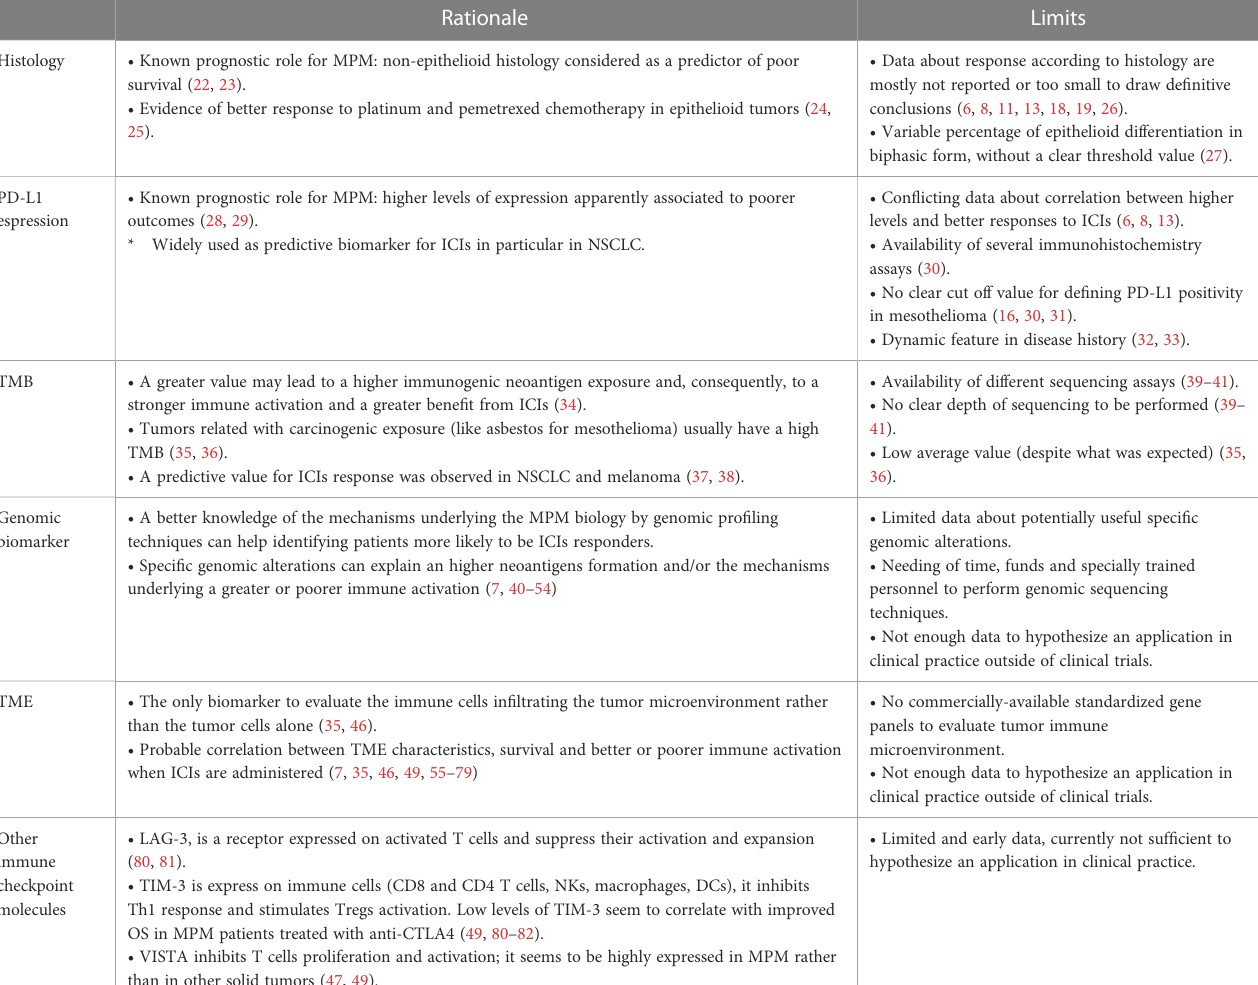
TABLE 2 Main predictive biomarkers under evaluation in